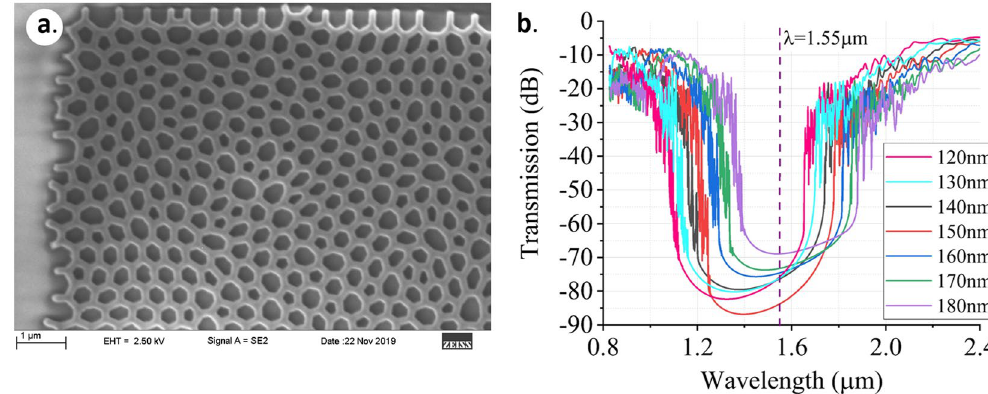
Figure 2. ( a ) Scanning electron micrograph image of a fabricated SOI HUD network structure with a wall width of 140 nm. ( b ) Simulated transmission results show that the position and width of the bandgap for the HUDS network with an average lattice spacing of 500 nm is tunable by varying the wall widths.